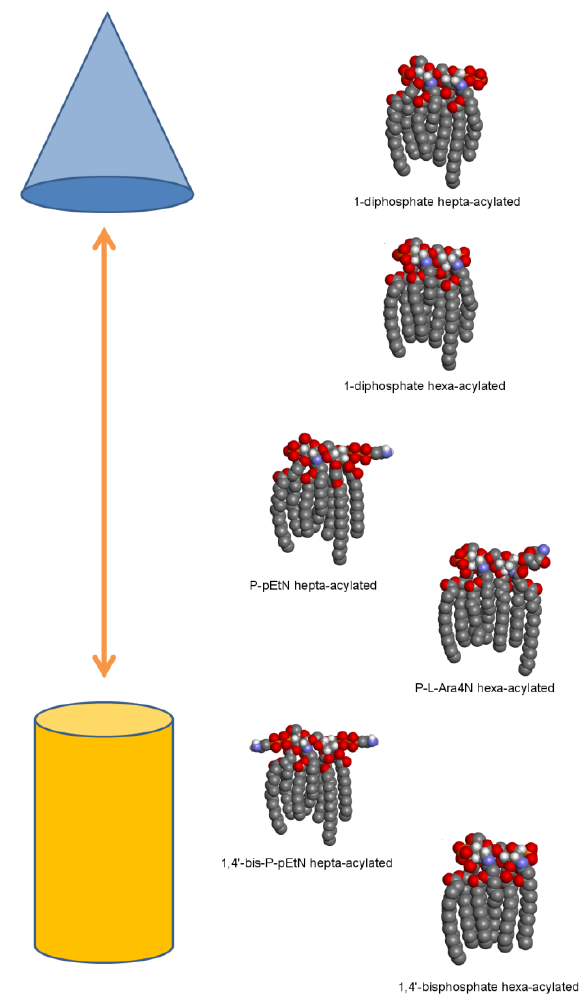
FIGURE 1: Model illustrating the diversity of lipid A structures and their preference for non-lamellar phase to lamellar phase in acidic conditions. Lipid A molecules are shown as three- dimensional space-filling models in typical Corey-Pauling-Koltun coloring (with the majority of hydrogen atoms omitted for simplic- ity). The proposed relative propensity of each lipid A structure towards the hexagonal phase (top, represented by a blue cone) or towards the lamellar phase (bottom, represented by an orange cylinder) is shown here. From top to bottom these lipid A struc- tures are shown from most to least likely to be found secreted in OMVs during 5.8L conditions according to ESI-MS